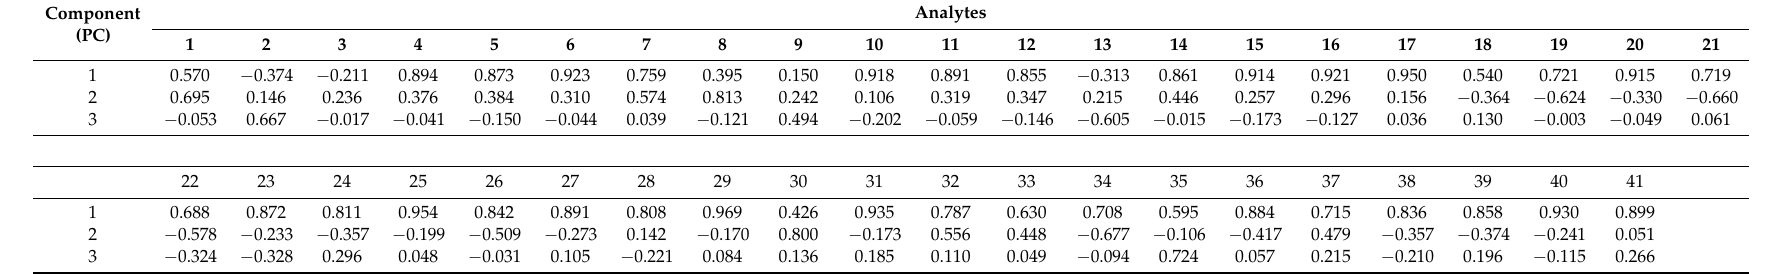
Table 4. Component loading matrix of 41 amino acids, nucleosides and nucleobases for